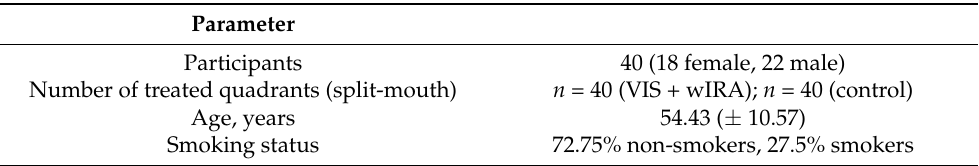
Figure 1. Consort diagram. VIS, visible light; wIRA, water-filtered infrared A; n stands for the number of study participants. Table 1. Demographic data at baseline (absolute numbers, mean ( ± sd), or percentages). VIS, visible light; wIRA, water-filtered infrared